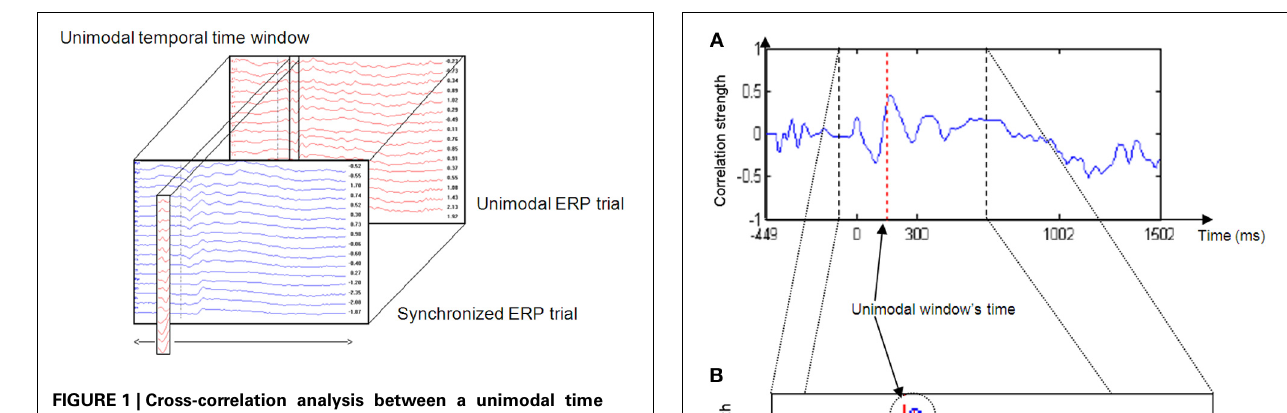
FIGURE 1 | Cross-correlation analysis between a unimodal time window throughout the crossmodaltrial.